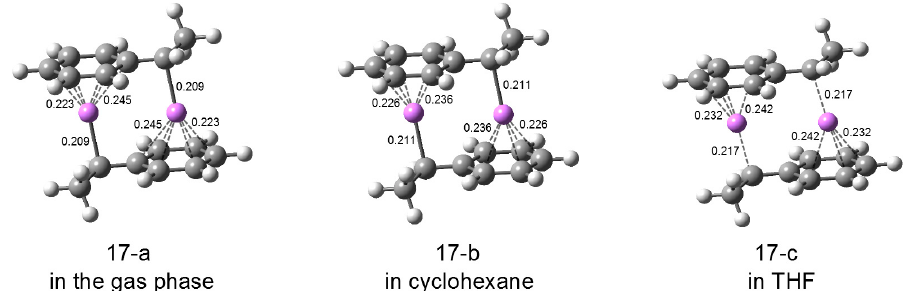
Figure 17. Geometries of (HStLi) 2 (1-a) in different environment. The ( α )C–Li distances and the shortest and the longest distances of the (phenyl)C–Li bonds are shown in nm.